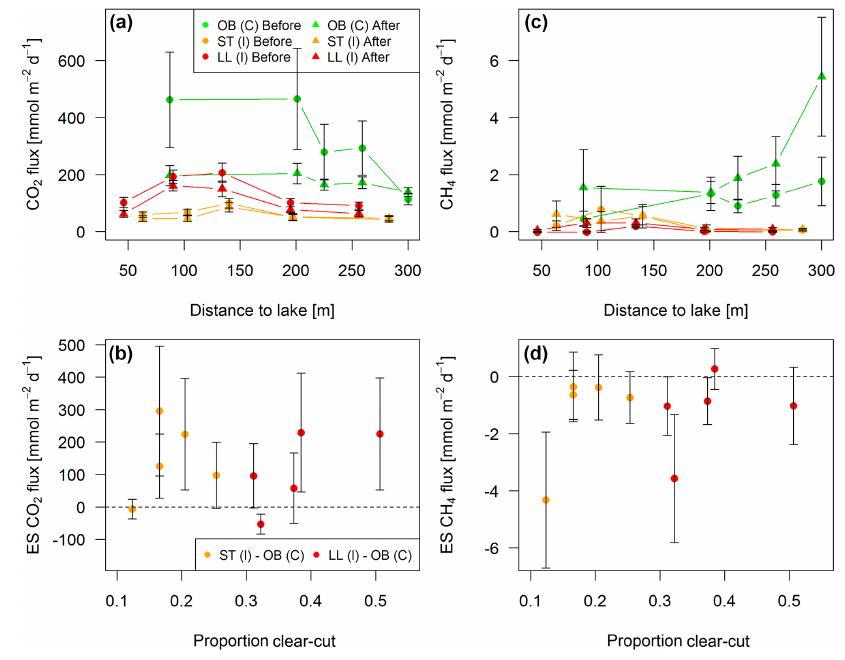
Figure 8. Fluxes of (a) CO 2 and (c) CH 4 across the stream–atmosphere interface along stream transects in the control catchment (C) and two impact catchments (I) before and after forest clear-cutting (OB = Övre Björntjärn, ST = Struptjärn, LL = Lillsjölidtjärnen,). Effect sizes (ES) defined as the before–after change in the difference between control and impact streams are shown in panels (b) and (d) . Each point represents seasonal mean values ( ± standard errors) of biweekly observations, summarized as arithmetic means over ten bootstrap runs that take uncertainty from gap-filling and gas flux models into account (see Fig. S3 and Text